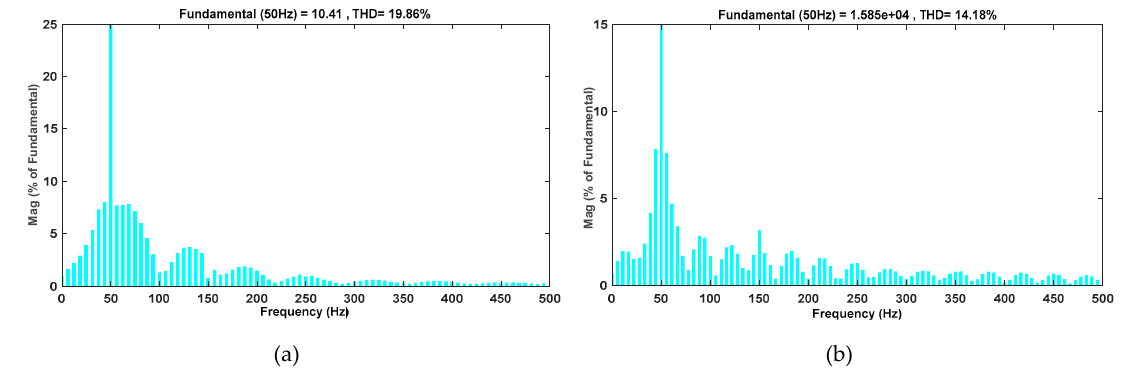
Figure 15. THD with LM + Crowbar scheme for grid current ( a ) and voltage ( b ) during the P-G fault.